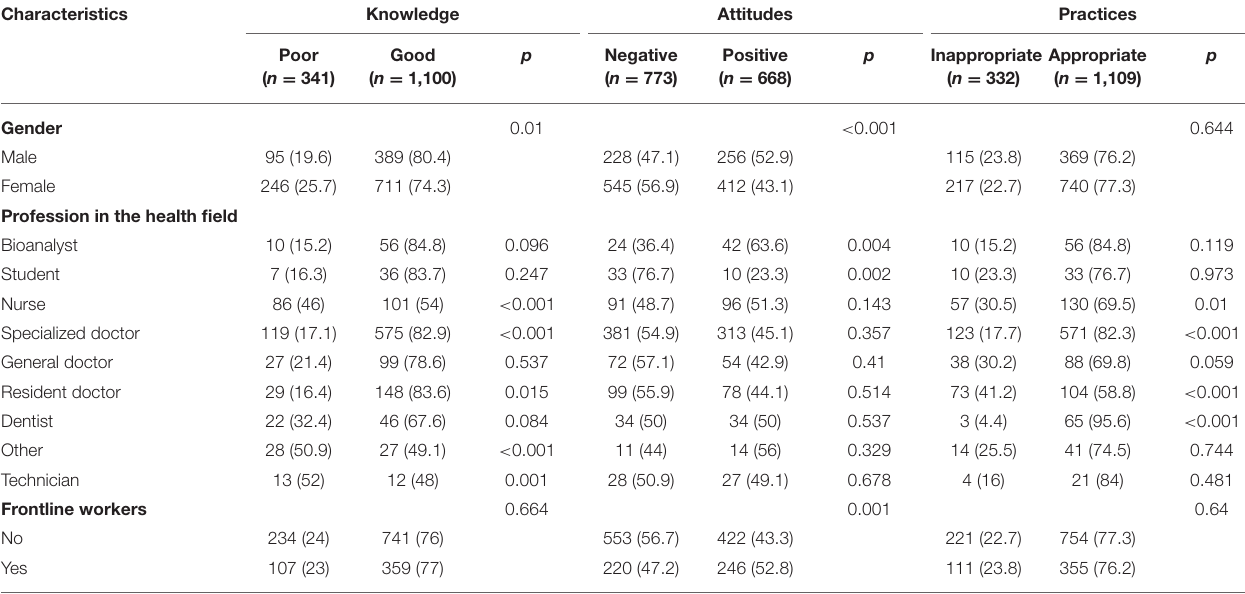
TABLE 3 | Factors associated with knowledge, attitudes, and practices